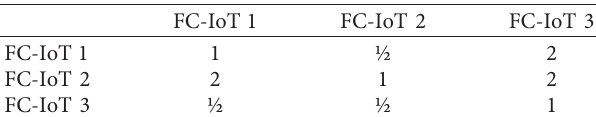
Table 5: Architecture 1.